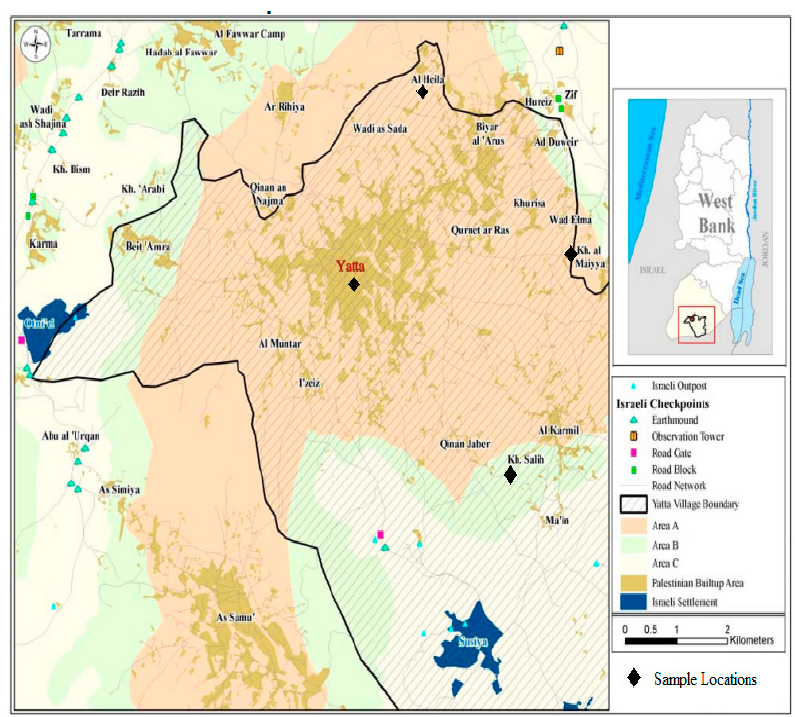
Figure 1. Study area including sampling localities in Yatta area [22].